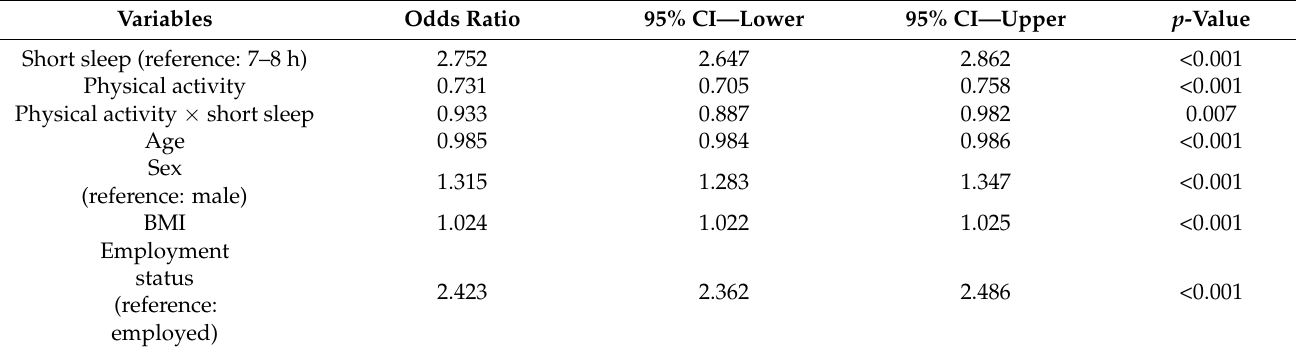
Table 8. The moderating effect of physical activity on the relationship between short sleep and emotional distress among Blacks and Whites ( n = 274,041).